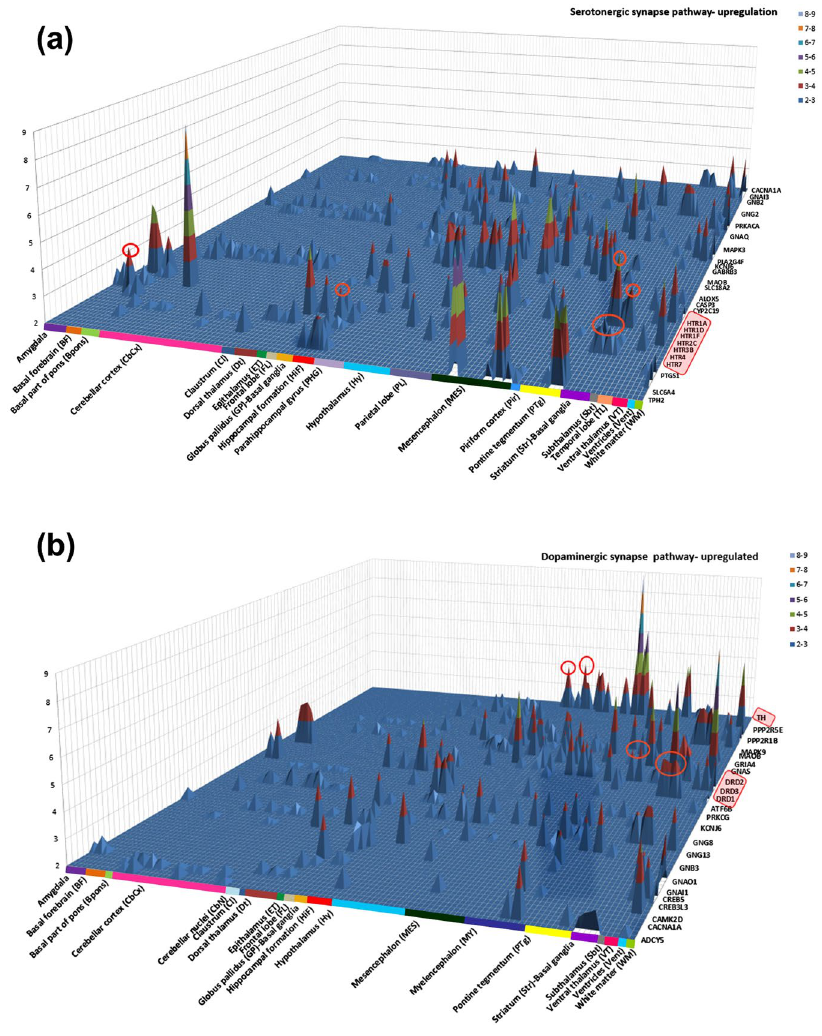
Figure 5. Structural distribution of gene expression in neurotransmitter systems. Distribution patterns of receptors shed light on the relation between anatomical units and their functions. (a) Serotonergic synapse showed spatial enrichment of HTR receptors in substantia nigra (mesencephalon) and globus pallidus (basal ganglia). (b) Dopaminergic synapse had significant enrichment of DRD receptors in striatum and